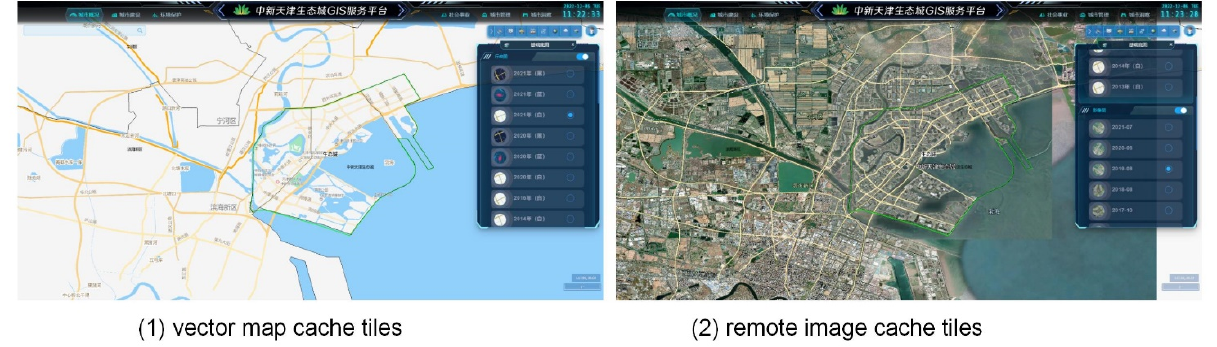
Figure 9. Application of the proposed model in a GIS project.